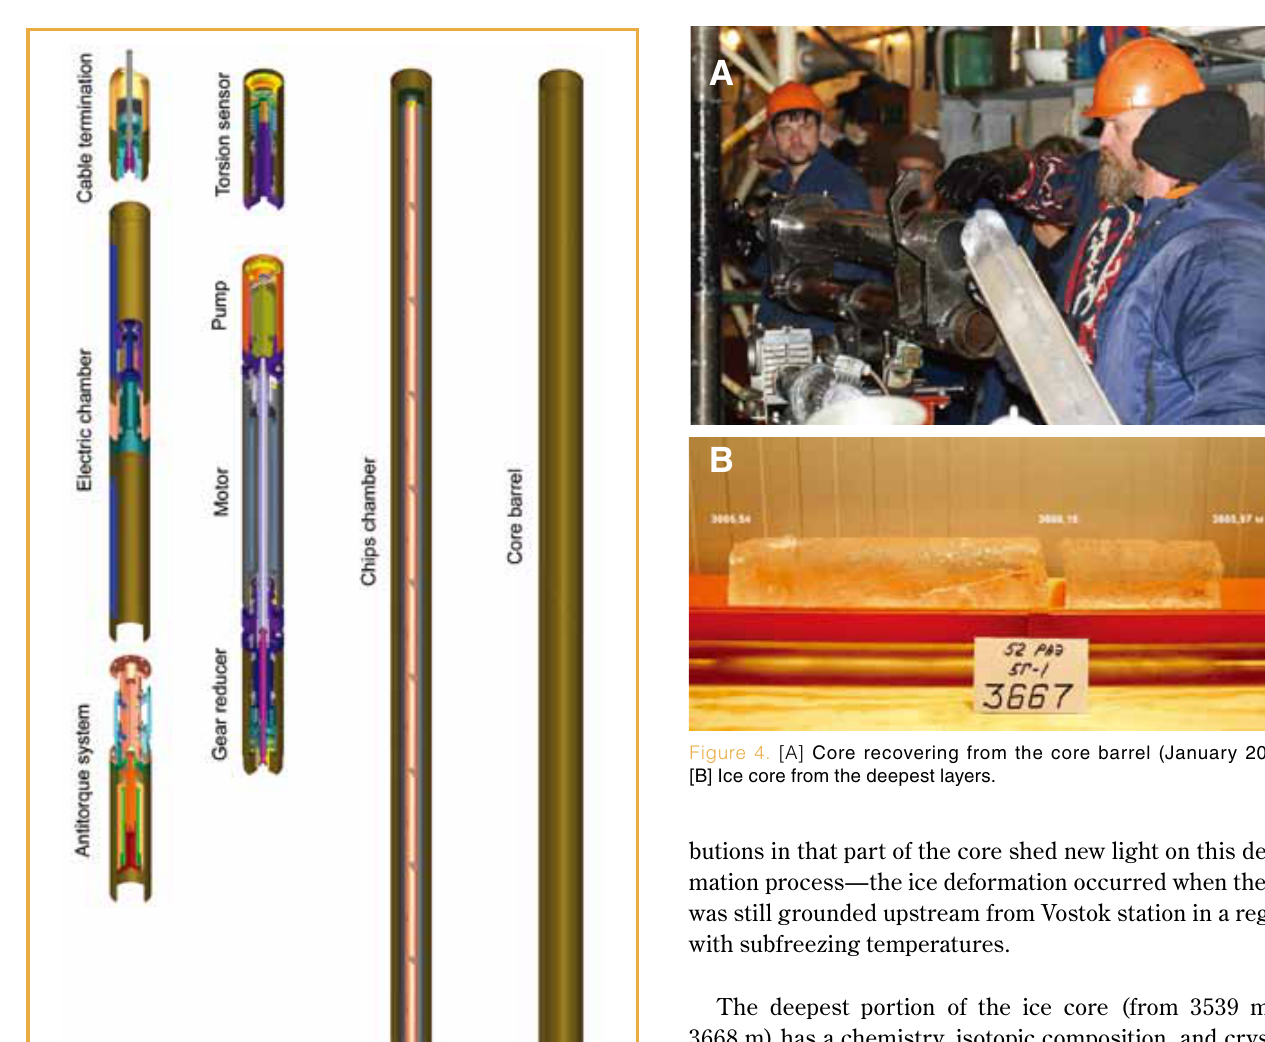
Figure 3. Electromechanical ice core drill KEMS-135.